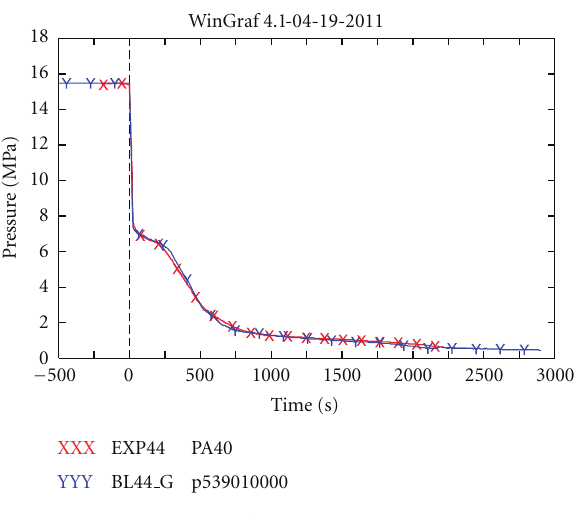
Figure 12: Primary system pressure.